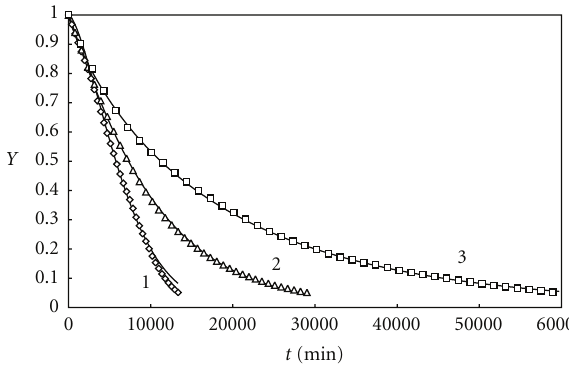
Figure 2: Mass loss kinetic curves at 300 ◦ C for arrays of the initial PDI of 1.14 (1), 2 (2), and 3 (3). Points show values obtained by simulation, and continuous lines show treatment results by the nonlinear regression